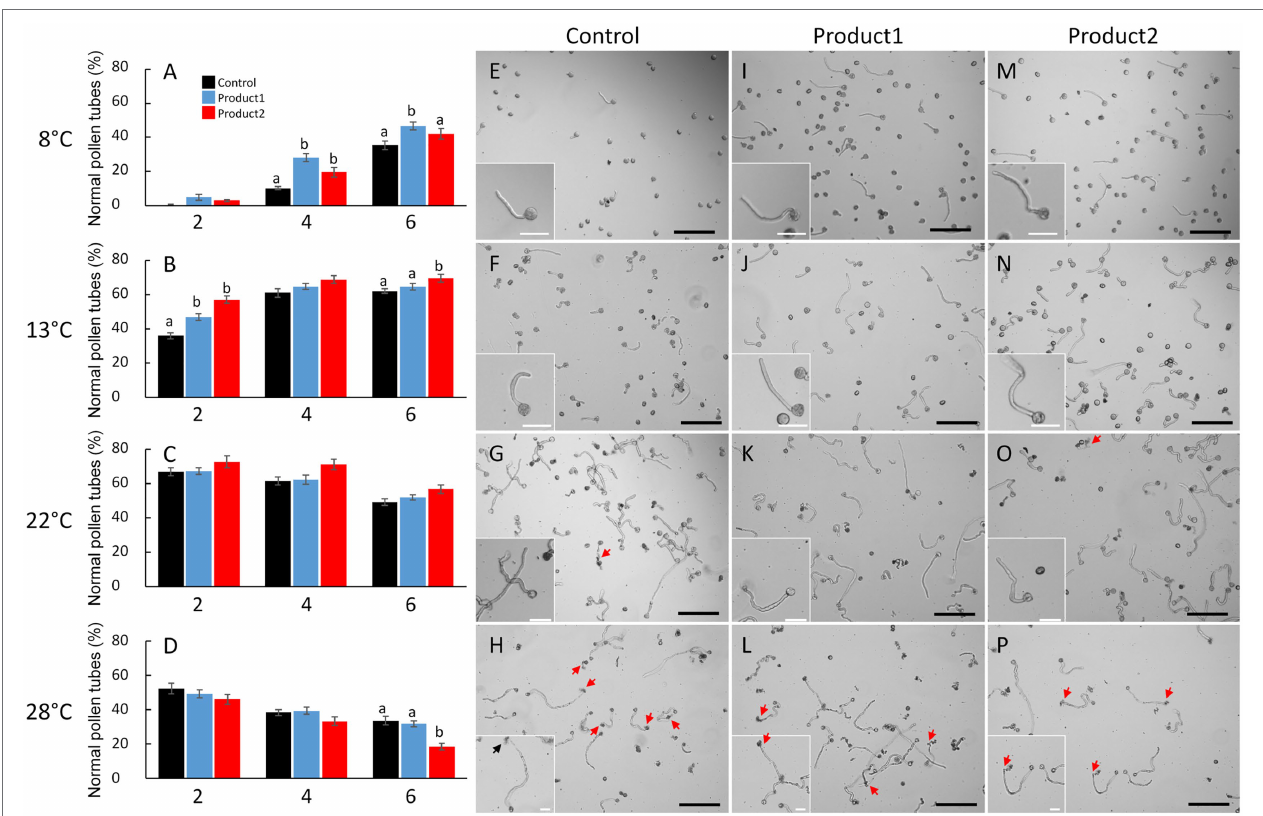
FIGURE 2 | Impact of temperature and treatments on tomato pollen tube integrity and morphology. (A–D) Percentages of normal pollen tubes after 2, 4, and 6 h of culture in the control condition (black bar) or in a medium supplemented with 2 μ g.ml − 1 of product 1 (blue bar) or product 2 (red bar). (E–P) Representative pictures of pollen germination and pollen tube after 4 h of culture in control condition (E–H) or in a medium supplemented with 2 μ g.ml − 1 of product 1 (I–L) or product 2 (M–P) . Experiments were carried out at 8 ° C (A,E,I,M) , 13 ° C (B,F,J,N) , 22 ° C (C,G,K,O) , and 28 ° C (D,H,L,P) . Statistical analyses were carried out by one-way ANOVA and significant differences were analyzed by Dunnett’s multiple comparison test. Data are marked by different letters when significantly different to the control conditions at each temperature ( p < 0.05). Scale bars represent 200 μ m in the main pictures and 40 μ m in the inserts. Arrows indicate burst